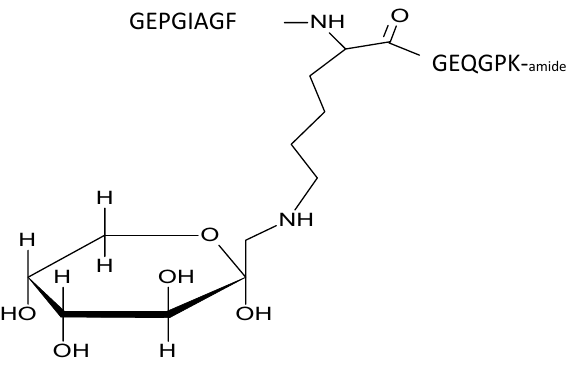
Figure 1. Novel fructosyl structure of peptide 90578. The peptide structure was modified by adding a cyclic fructosyl structure to the lysine residue. To enhance legibility, this lysine residue is shown as chemical structure, whereas the other amino acids of the peptide are just indicated as single letter